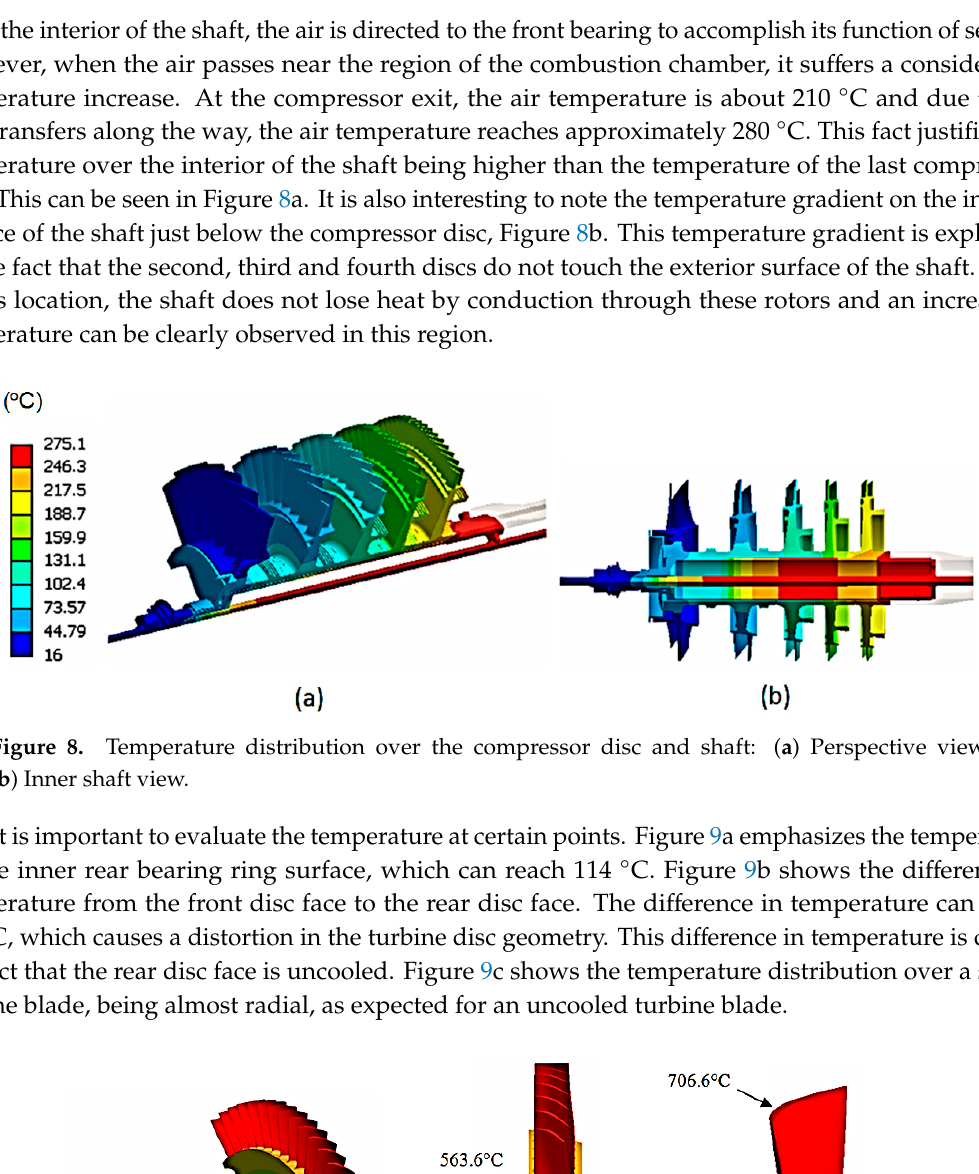
Figure 10. Temperature distribution over one eighth section of the static assembly.